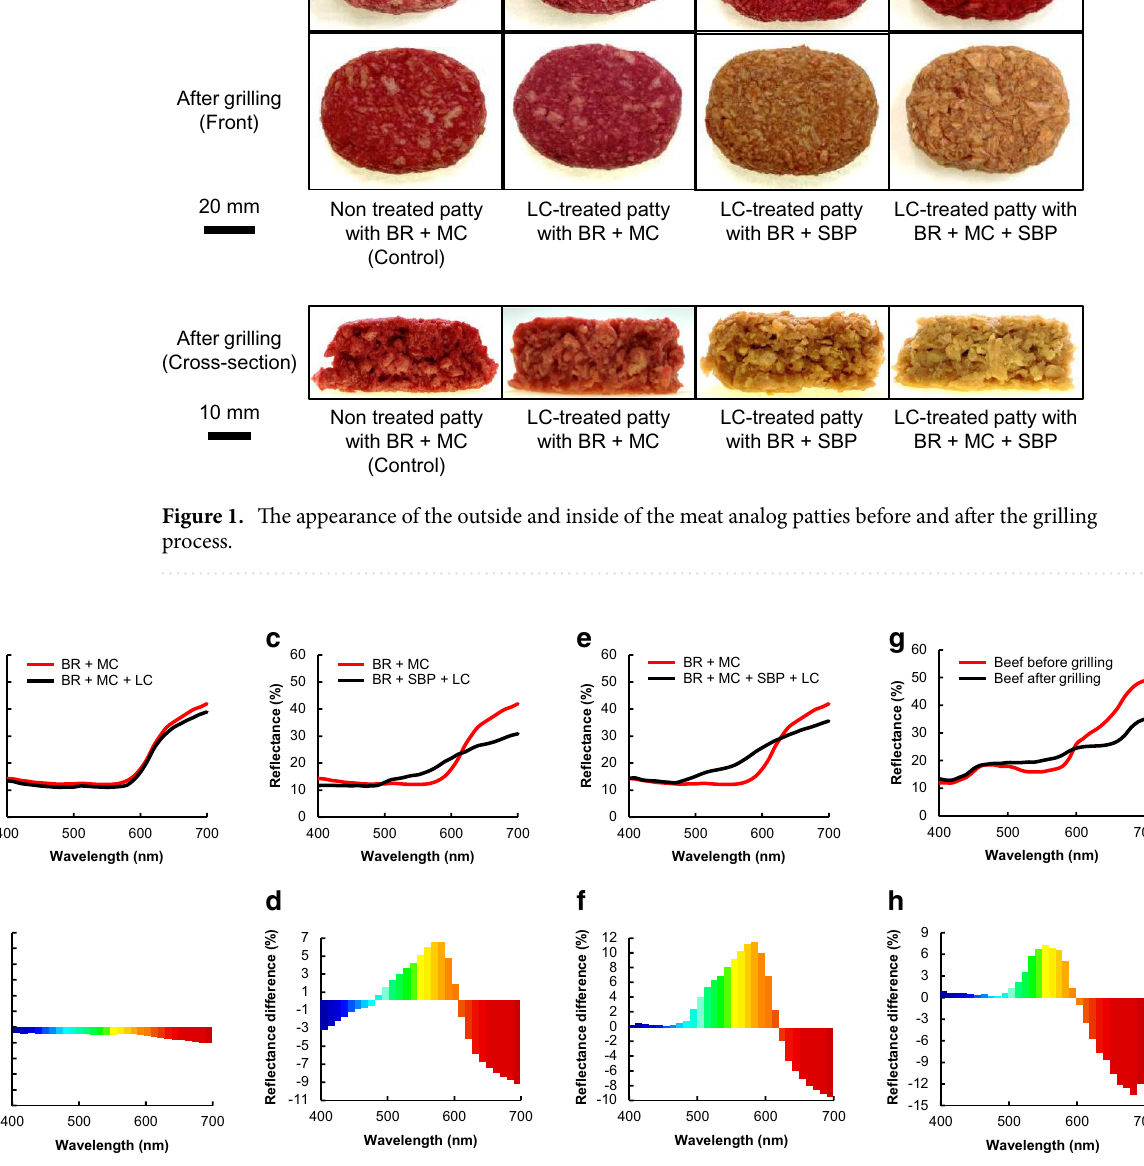
Figure 2. Reflectance of meat analog patties and beef patties. The reflectance values of ( a , b ) LC-treated patties containing BR + MC, ( c , d ) LC-treated patties containing BR + SBP, and ( e , f ) LC-treated patties containing BR + MC + SBP were measured using a colorimeter. Non-treated patties with BR + MC were used as controls. ( g , h ) Beef patties before and after